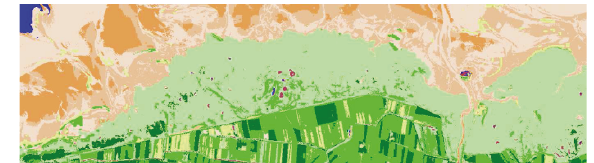
Figure 14: The final unification result.